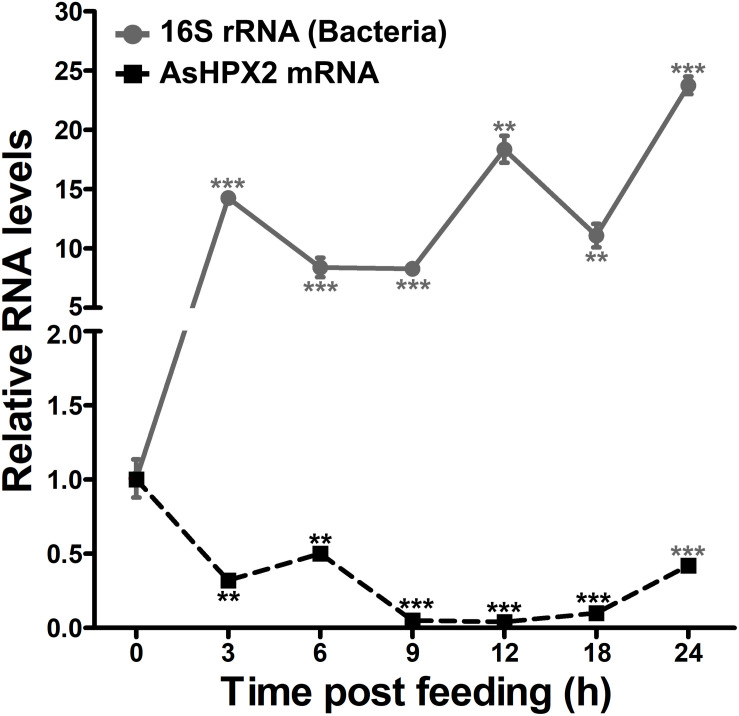
Expression kinetics of AsHPX2 gene in blood-fed midguts. Relative mRNA levels of AsHPX2 gene or 16S rRNA were analyzed in midguts collected at different time points after blood-feeding. The relative levels of AsHPX2 mRNA and 16S rRNA were calculated against the respective sugar-fed midguts, which were considered as 1.0. Significant differences (p < 0.001 or 0.01) are indicated by three or two asterisks, respectively.